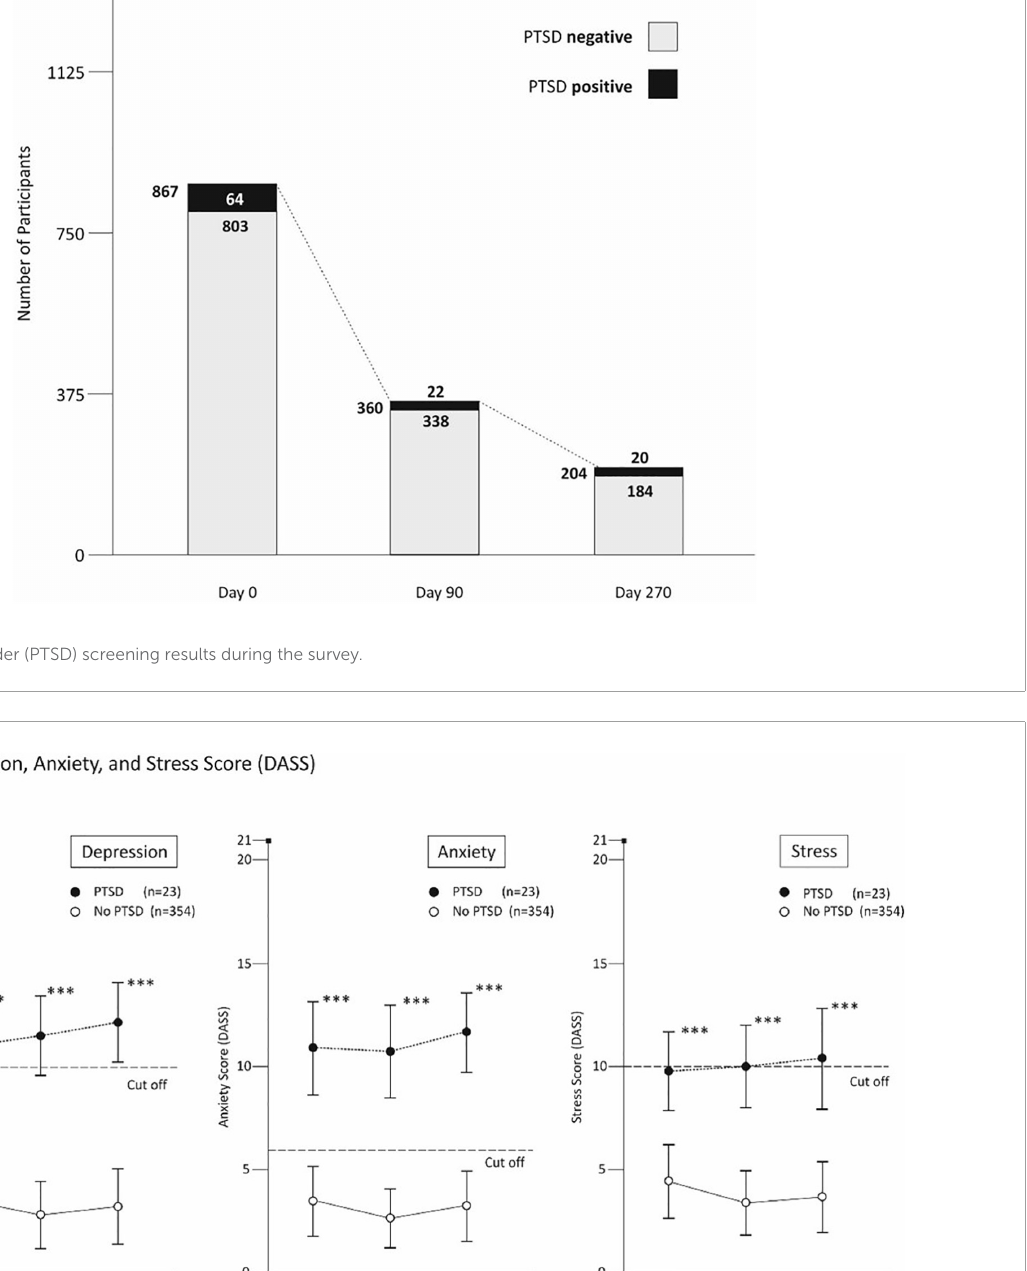
based on the non-significant Hosmer-Lemeshow test, p = 0.461. By means of stepwise backward selection, FKK-SK ( p = 0.001, OR = 0.92, 95%-KI [0.87; 0.97]) remained as a protective factor and FFK-C ( p = 0.009, OR = 1.08, 95%-KI [1.02; 1.36]) as a risk factor with significant explanatory value for the occurrence of PTSD in the last model step. The coefficient of determination for the explained proportion of variance according to Nagelkerke’s R 2 reached